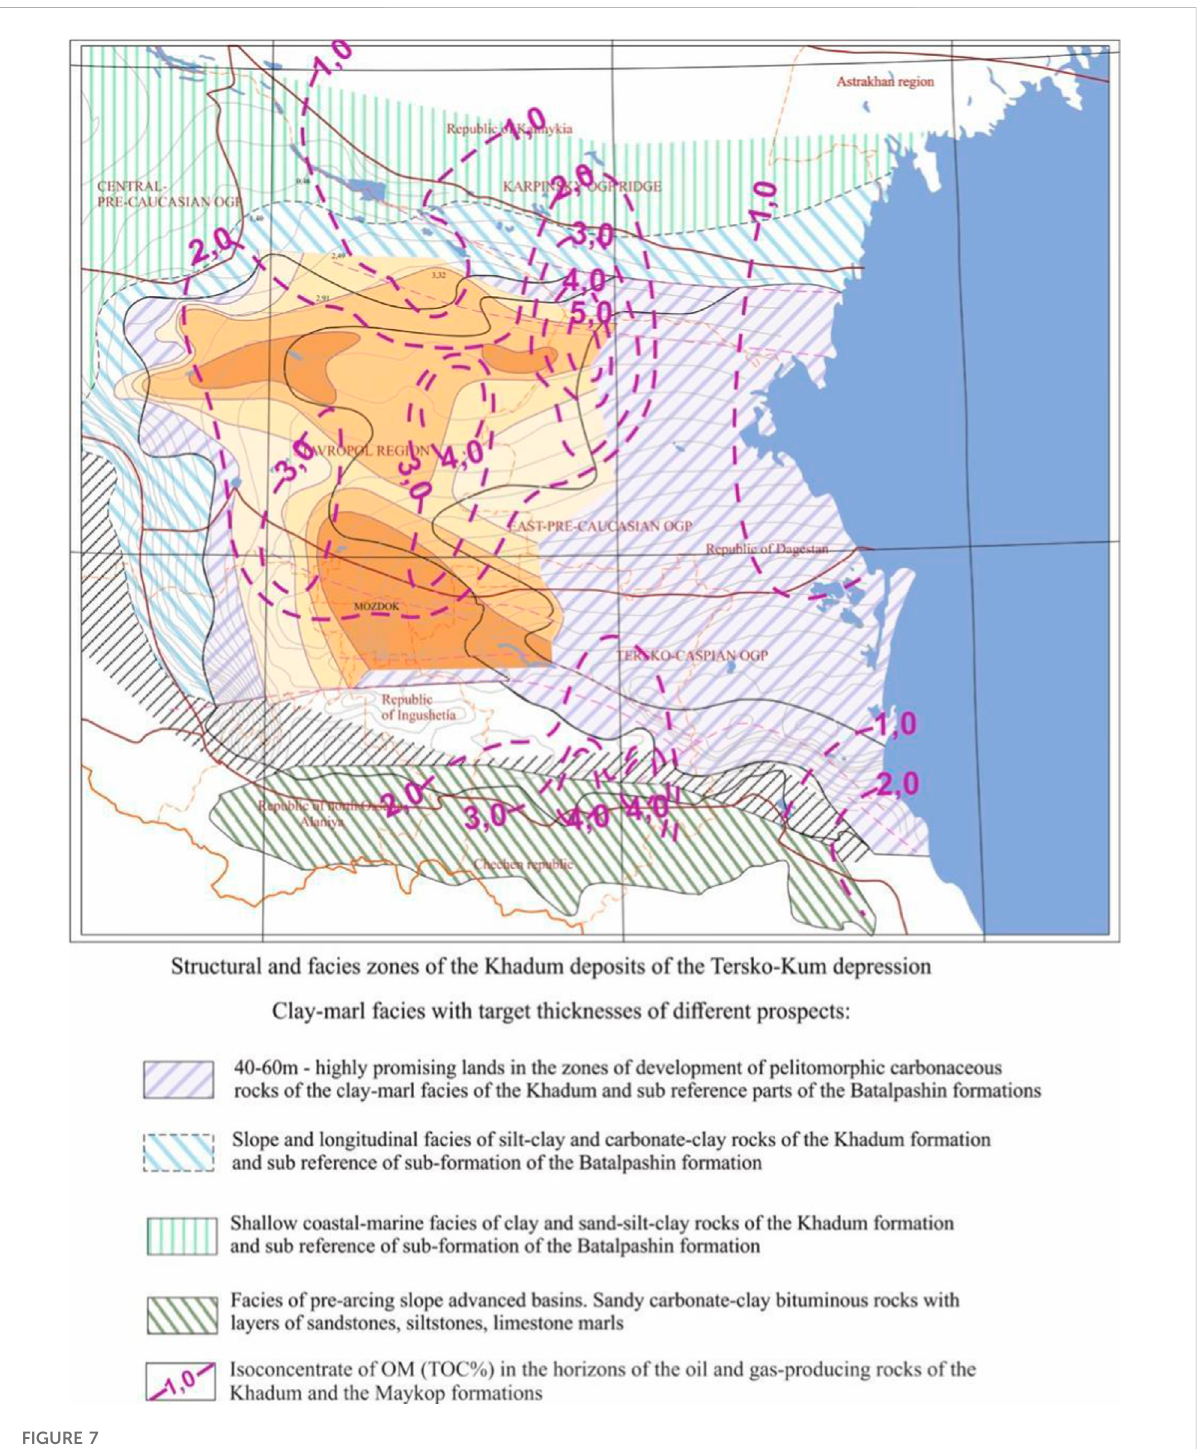
FIGURE 7 Distribution of the Khadum formation within the Tersko-Kum depression (North Caucasian-Mangyshlak OGP) (Bazhenova et al., 2008; Guliyev et al., 2018; Kerimov et al., 2021).